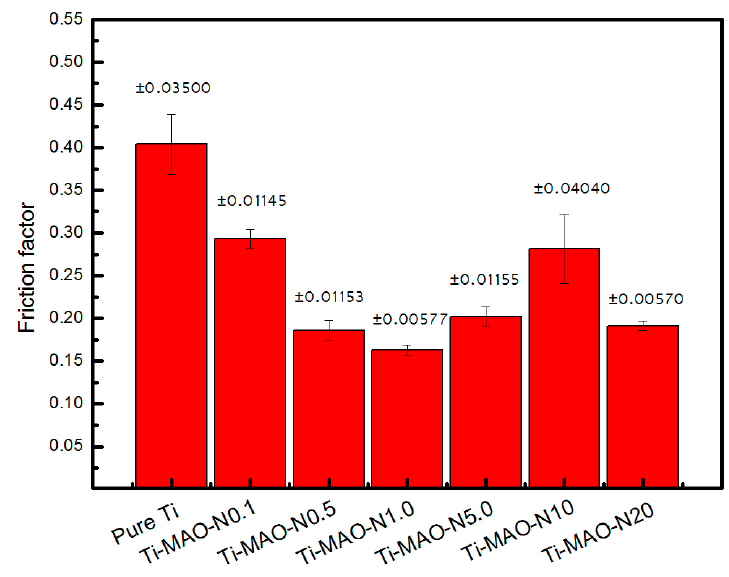
Figure 6. Friction coefficient of MAO specimens with different N doses under 50% mavericks serum lubrication conditions.